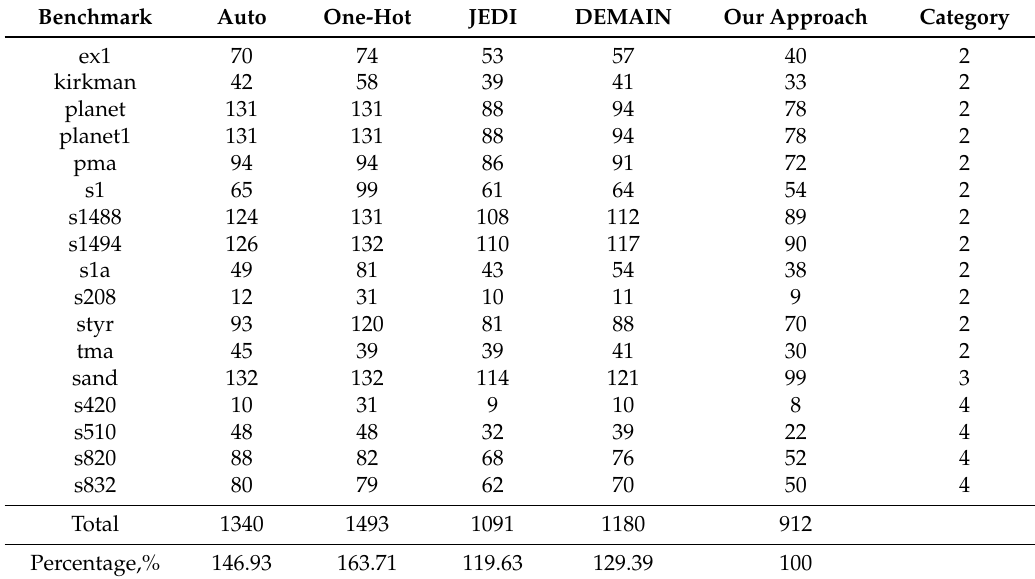
Table 9. Experimental results for categories 2-4 (the number of